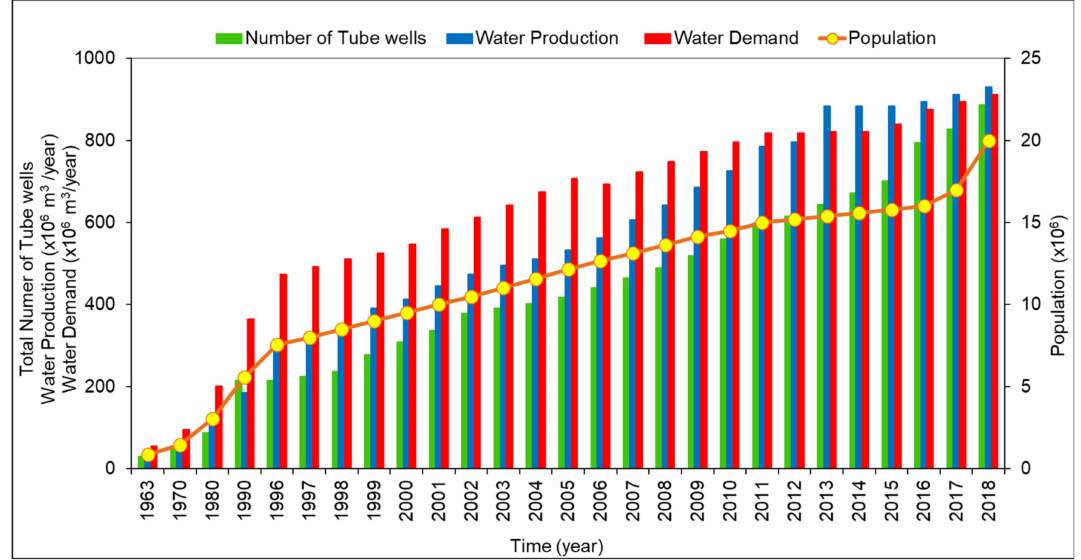
Figure 6. The number of DTWs, water demand and production, and population